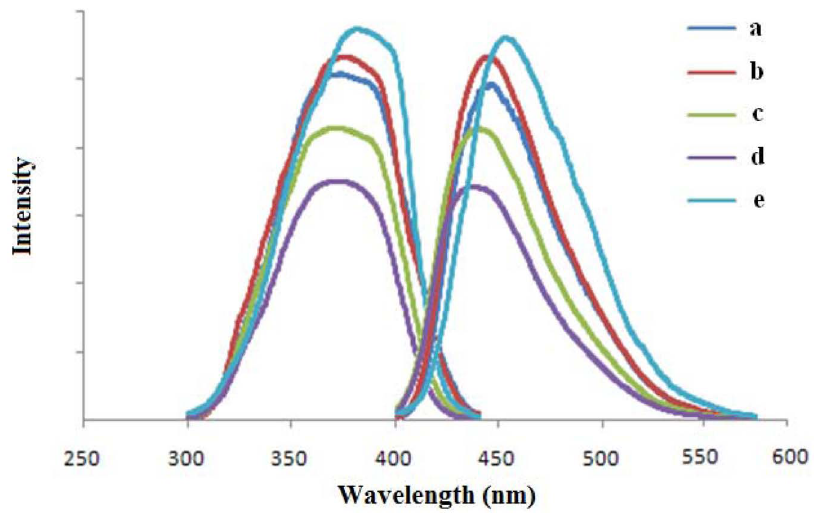
Figure 8. Experimental fluorescence spectra of a–e.